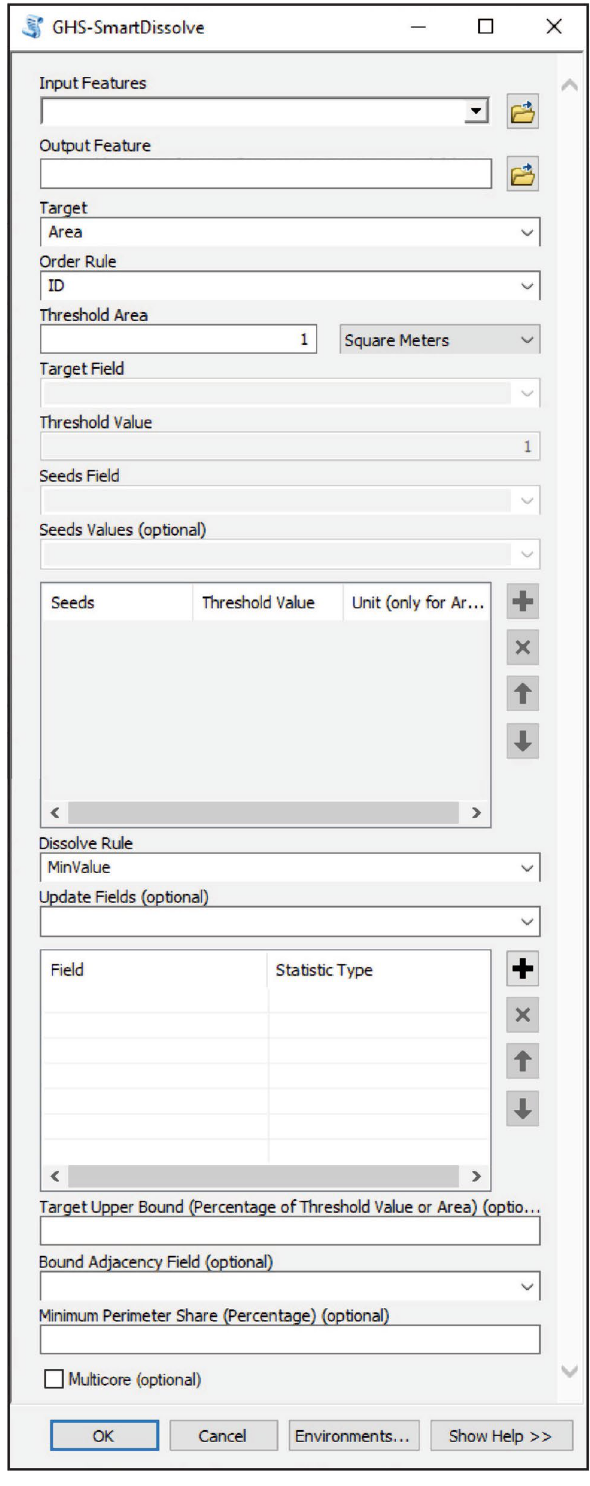
Figure 2. ‘GHS-SmartDissolve’ ArcGIS (Esri) toolbox